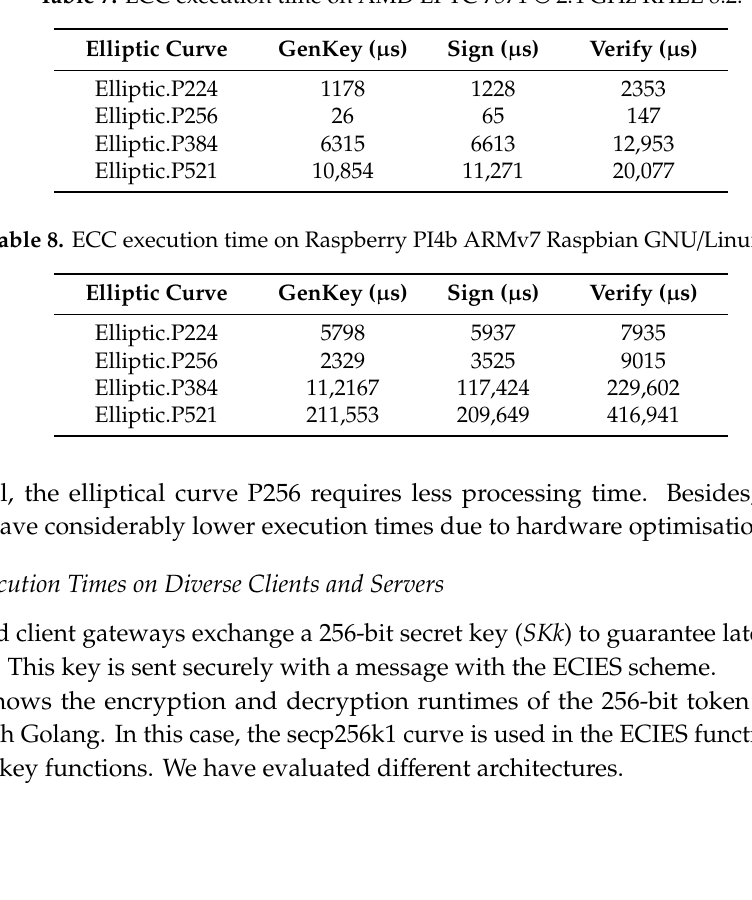
Table 7. ECC execution time on AMD EPYC 7571 @ 2.4 GHz RHEL 8.2.